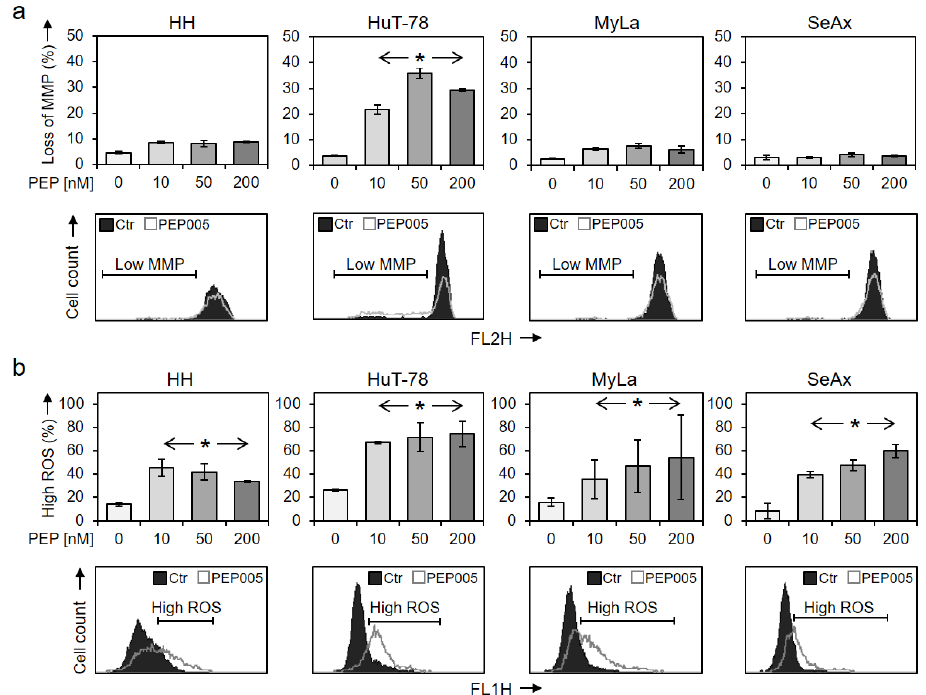
Figure 3. Loss of mitochondrial membrane potential and enhanced ROS levels. Changes of ( a ) mitochondrial membrane potential (MMP) and of ( b ) ROS levels were determined at 24 h of treatment with 10, 50 and 200 nM PEP005. Mean values of triplicates ± SDs are shown; a second independent series of experiments revealed highly comparable results. Representative histograms (overlays of treated cells vs. controls) are given below the bar charts, and cells with low MMP ( a ) or with high ROS ( b ) are indicated. Statistical significance was calculated from two independent experiments (at least six values) and is indicated for treated cells vs. controls (* p < 0.05).